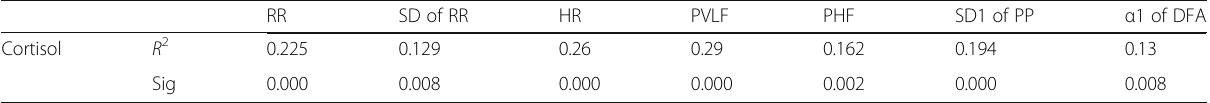
Table 2 The R 2 and significance of cubic regression between the level of salivary cortisol and HRV features in the 98 tests RR SD of RR HR PVLF PHF SD1 of PP α 1 of